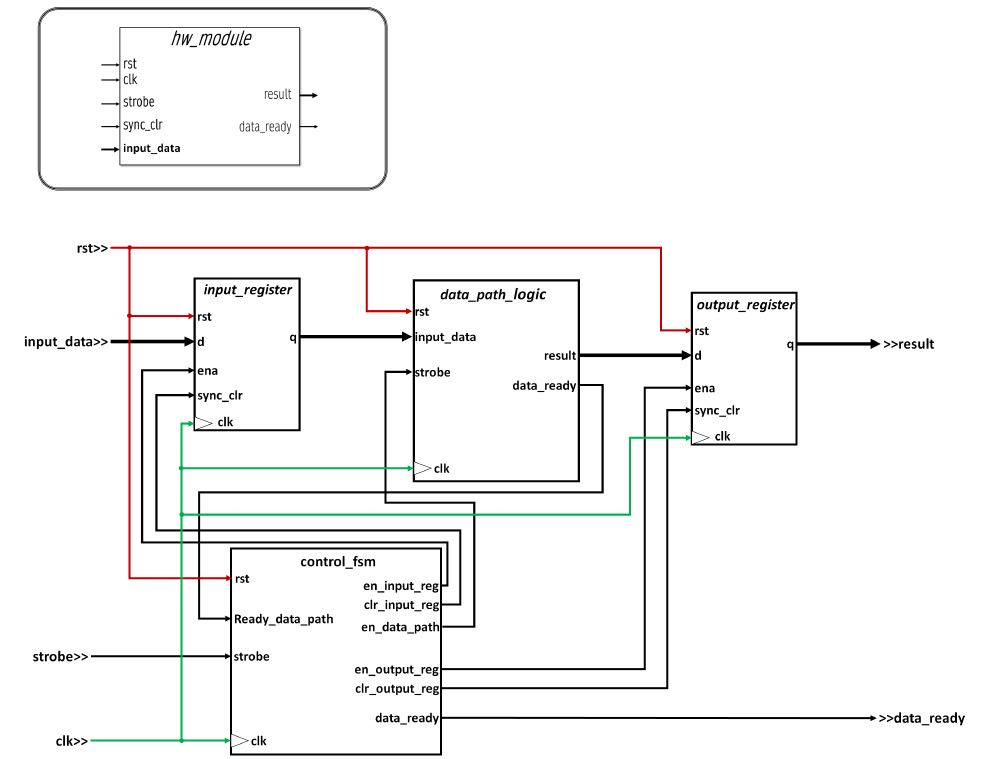
Figure 5. Generic module architecture in hardware—OCP interface +